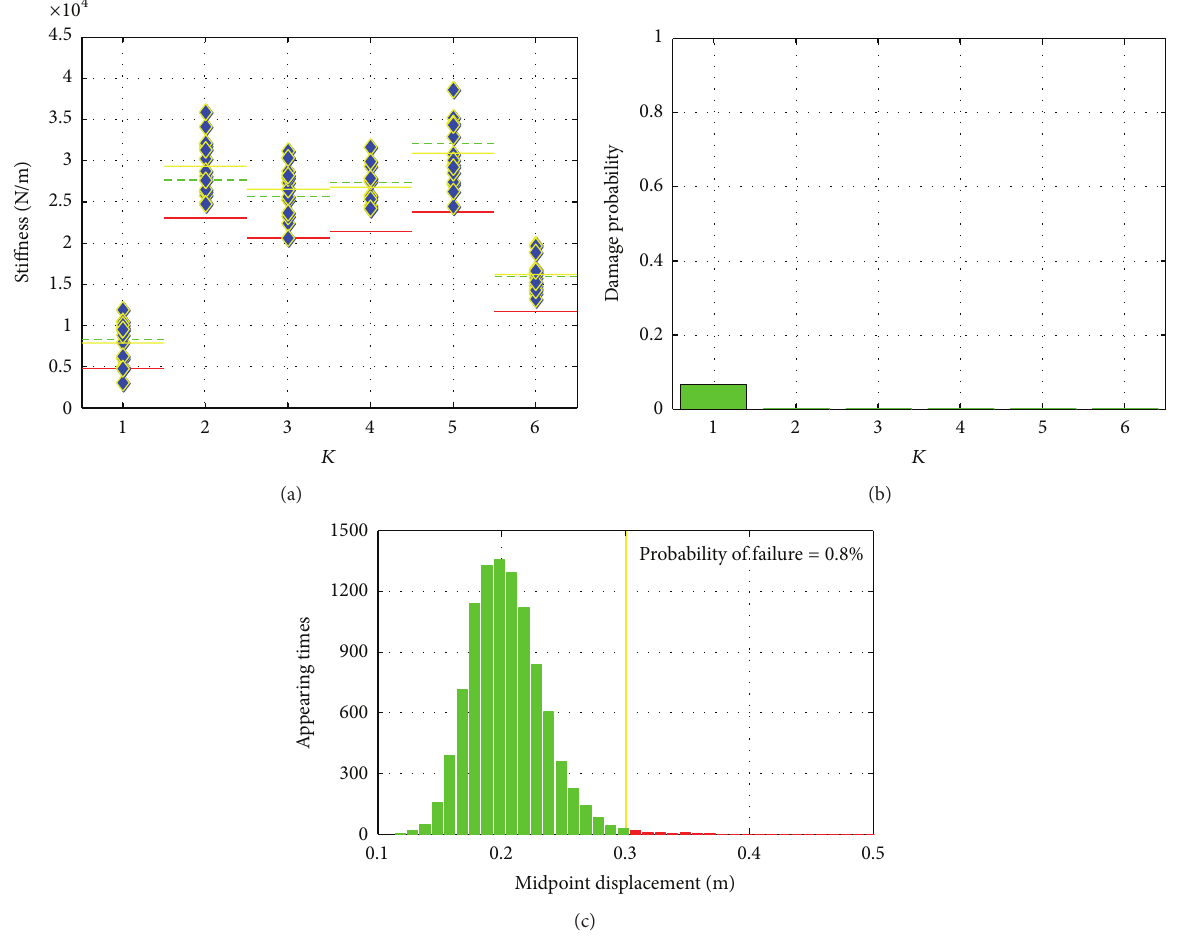
Figure 11: Results of damage scenario no.